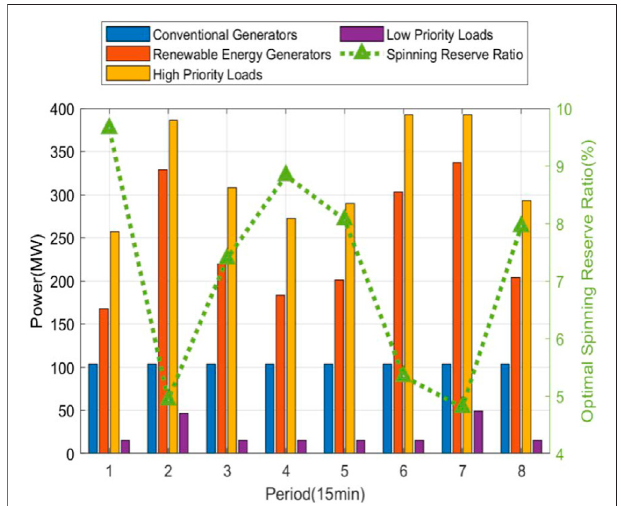
FIGURE 3 | Results of optimal variables.